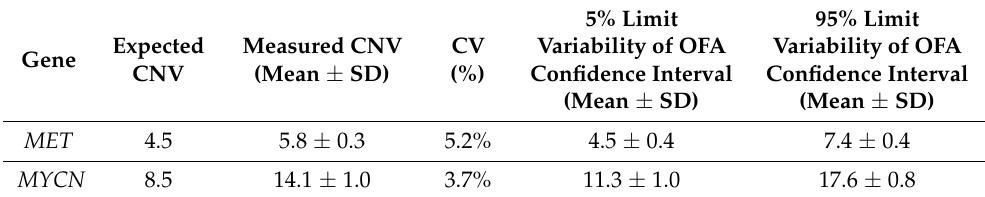
Table 2. Inter-run variation of gene amplification analysis using HD789 QC material in 20 consecu- tive runs.